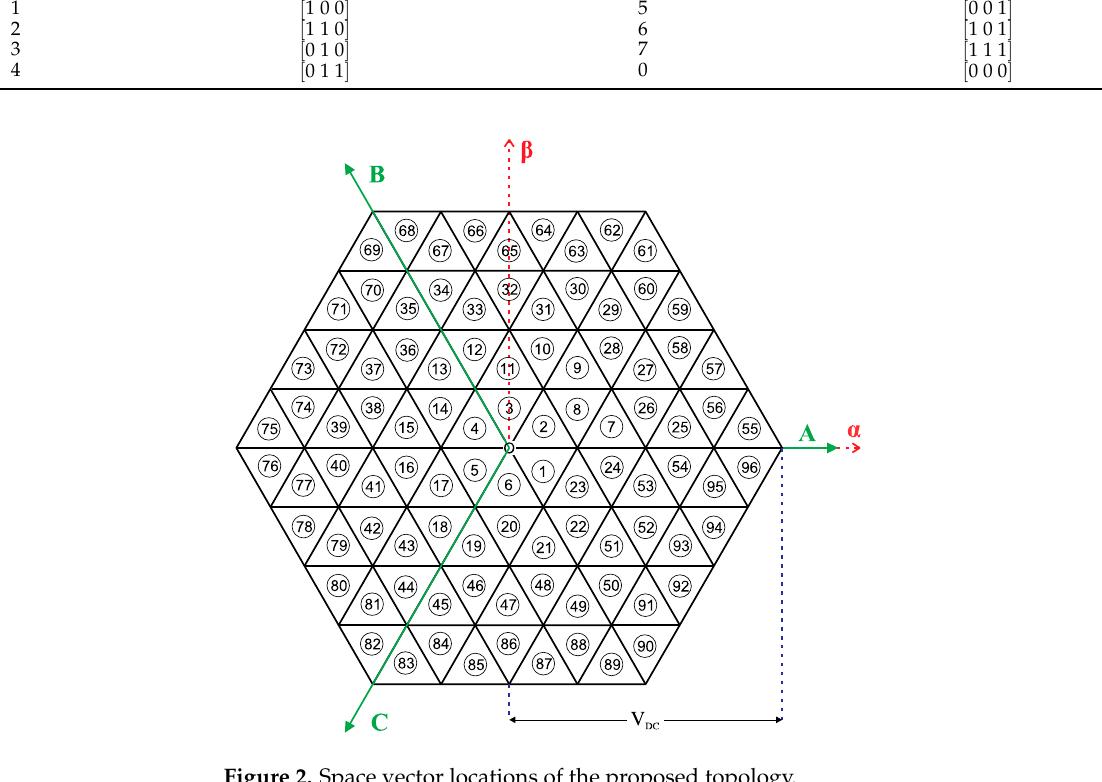
Figure 2. Space vector locations of the proposed topology. Table 1. Switching states of the individual three-phase inverters.